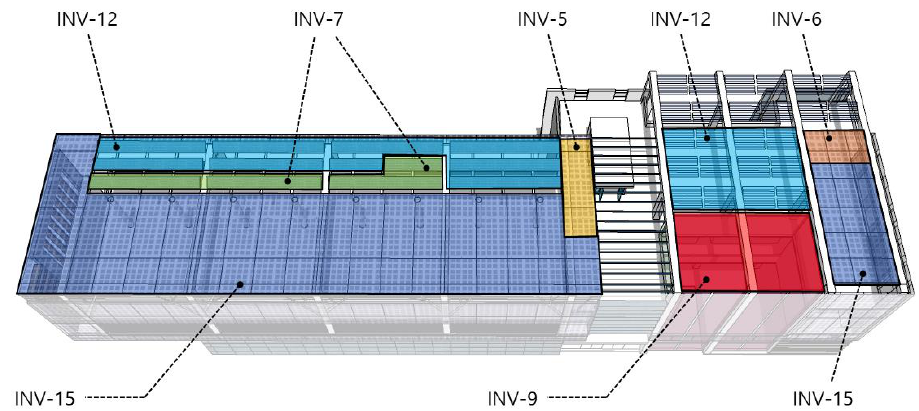
Figure 2. Detailed diagram of the building-integrated photovoltaic (BIPV) array installation on the southern façade of the Carbon Zero Building.